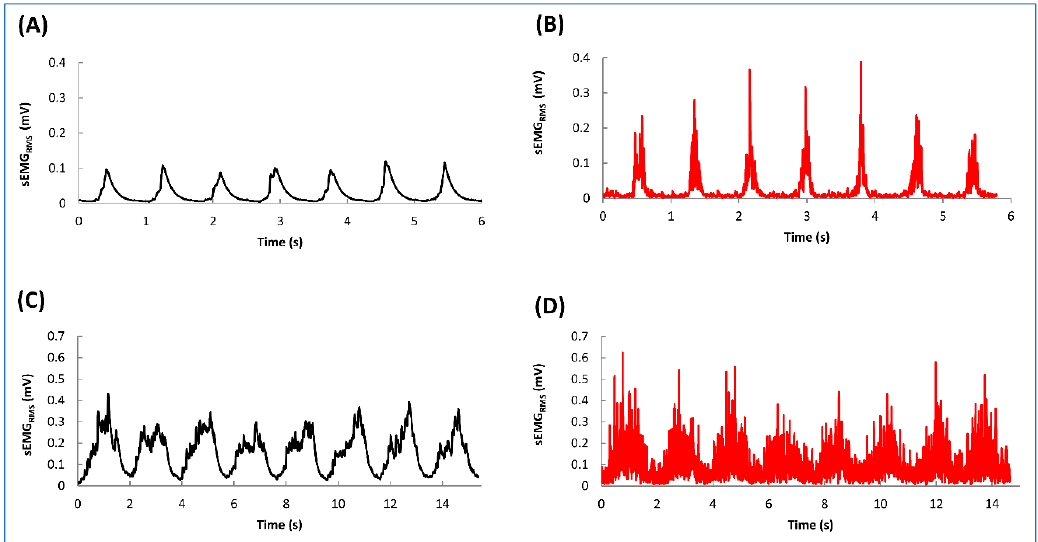
Figure 6. Representative example of the surface electromyographic activity (sEMG RMS ) recorded on the right (wiNIREM, B , D ) and the left (Muscle Lab, A , C ) vastus lateralis (VL) during an epoch (seven foot contacts) of submaximal treadmill run at 10 km/h ( A , B ) and during an eight repetitions of dynamic high squat ( C , D ). The running patterns (contact and aerial phases) can be easily identified. For the details see the “Material and Methods” section.